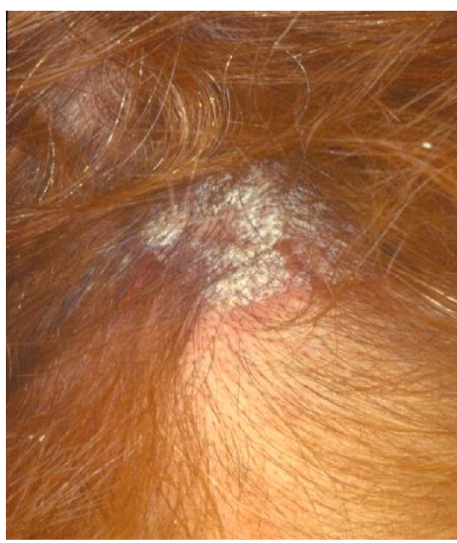
Figure 1: Psoriasis lesion on the patient ’ s hair